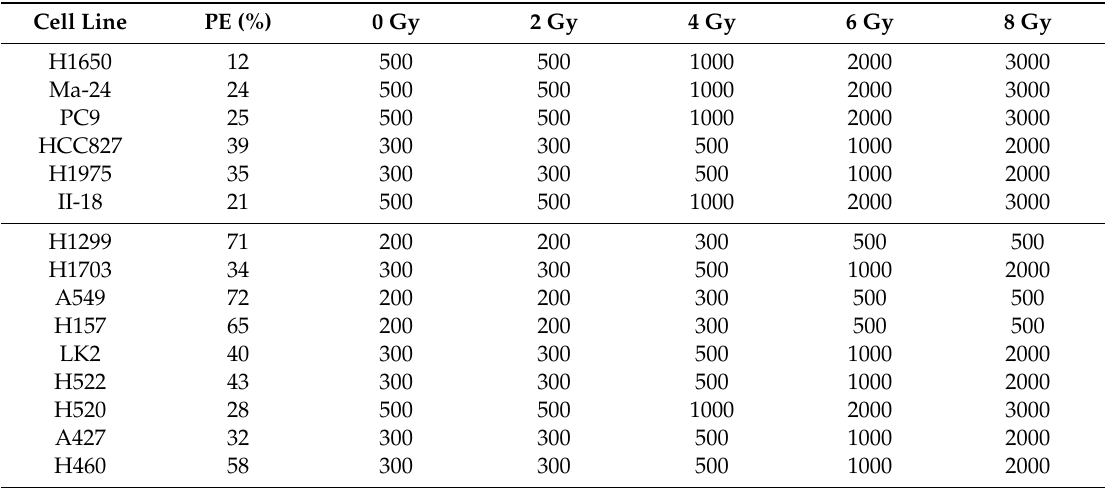
Table 4. Plating e ffi ciency (PE) and the number of seeded